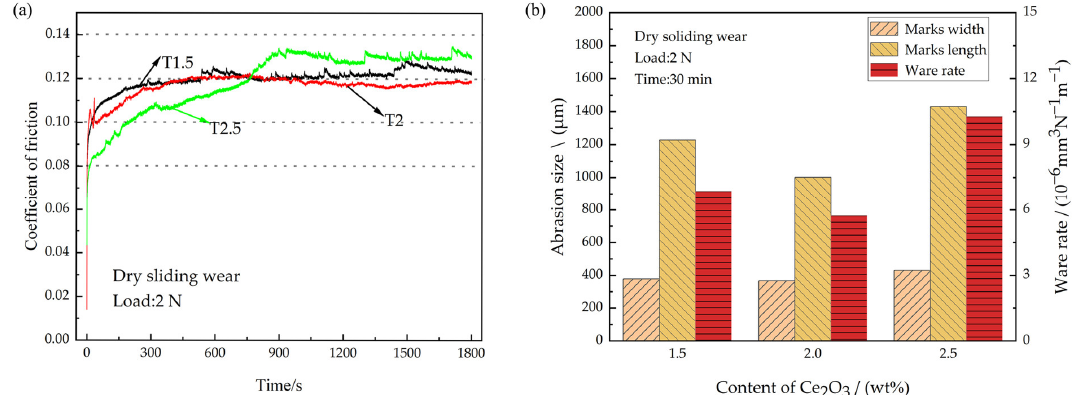
Figure 8. CoFs and wear amount under dry sliding wear. ( a ) Coefficient of friction; ( b ) Wear amount.